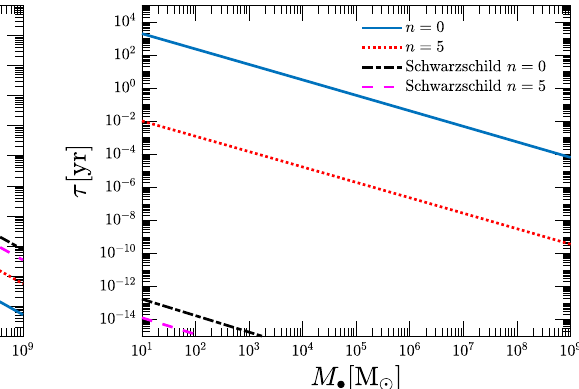
ences are negligible in the scales used. Any larger value of K we tried ( ≤ 15) gives also identical results. Differences in the precise value of ε are also negligible. There are also depicted the values of Schwarzschild black holes for